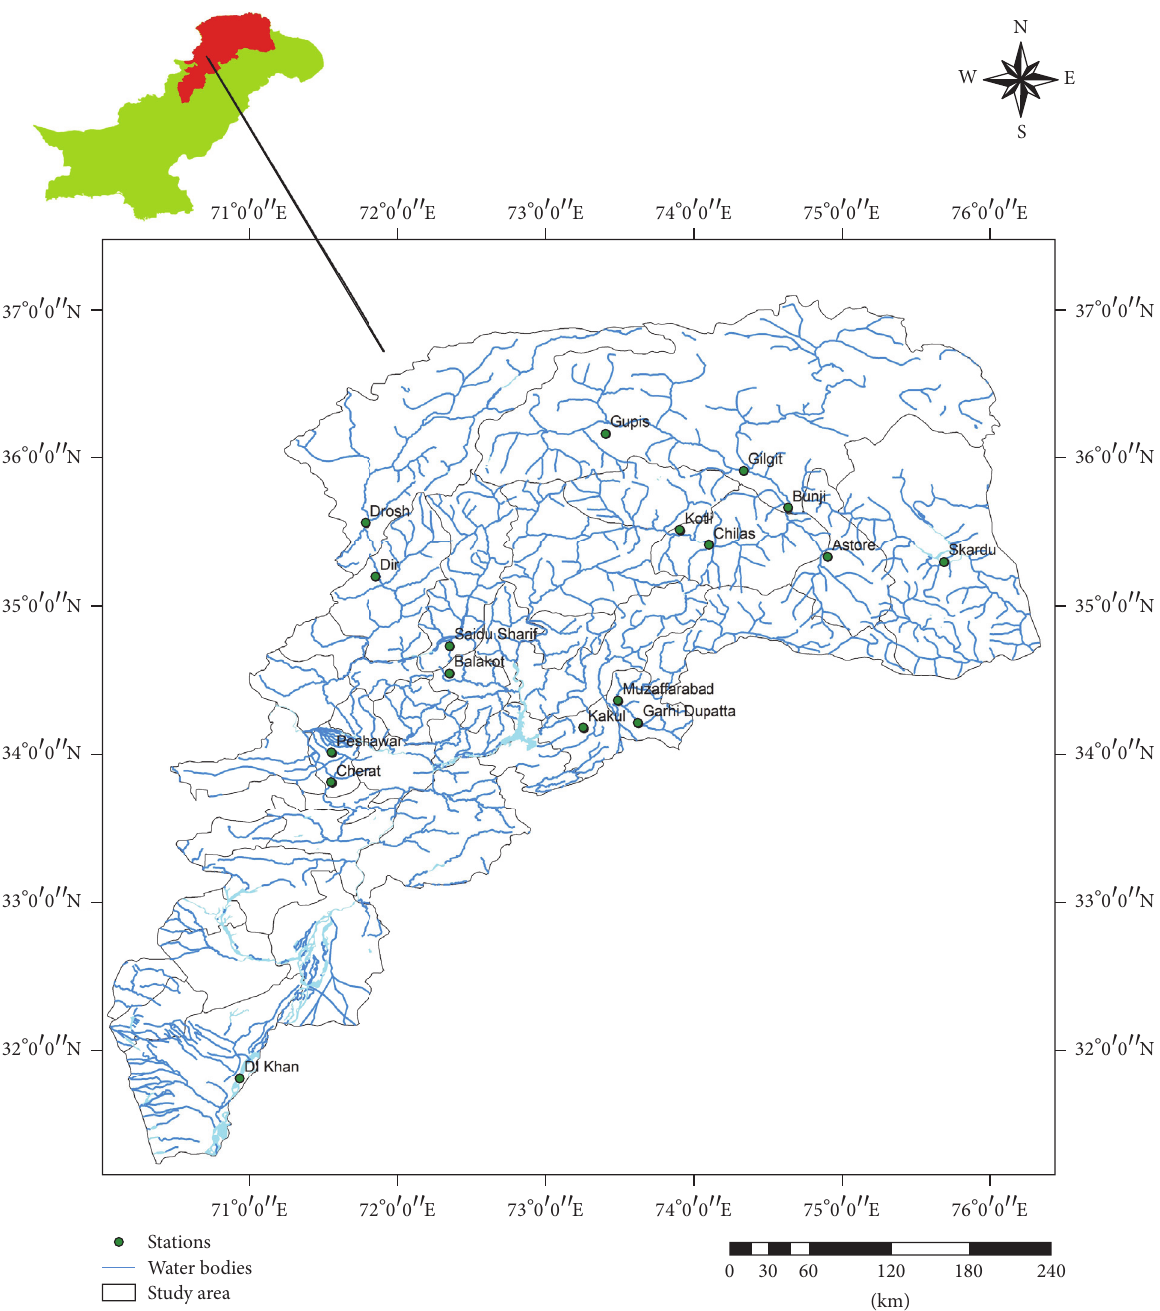
Figure 1: Locations of Northern areas and Khyber Pakhtunkhwa and the meteorological stations ( 𝑥 axis indicates Longitude [ E ] ; 𝑦 axis indicates Latitude [ N ]